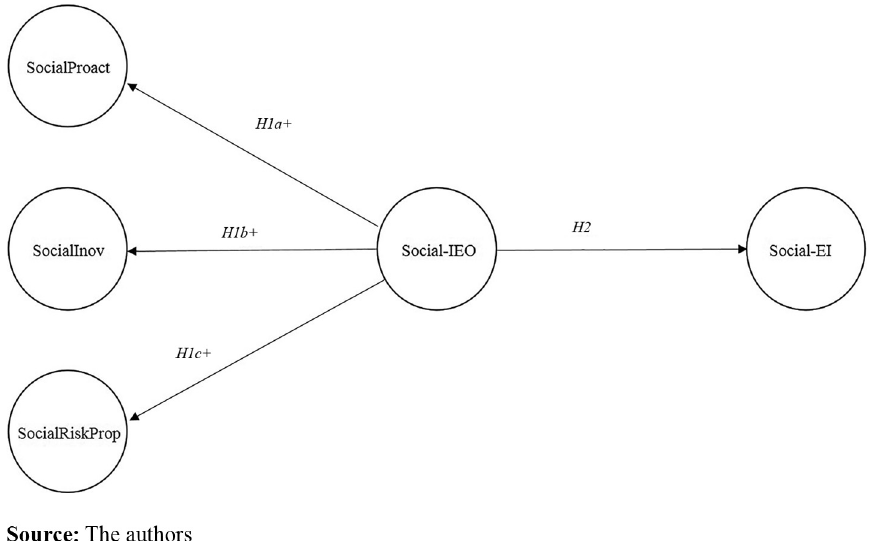
Figure 1. Conceptual